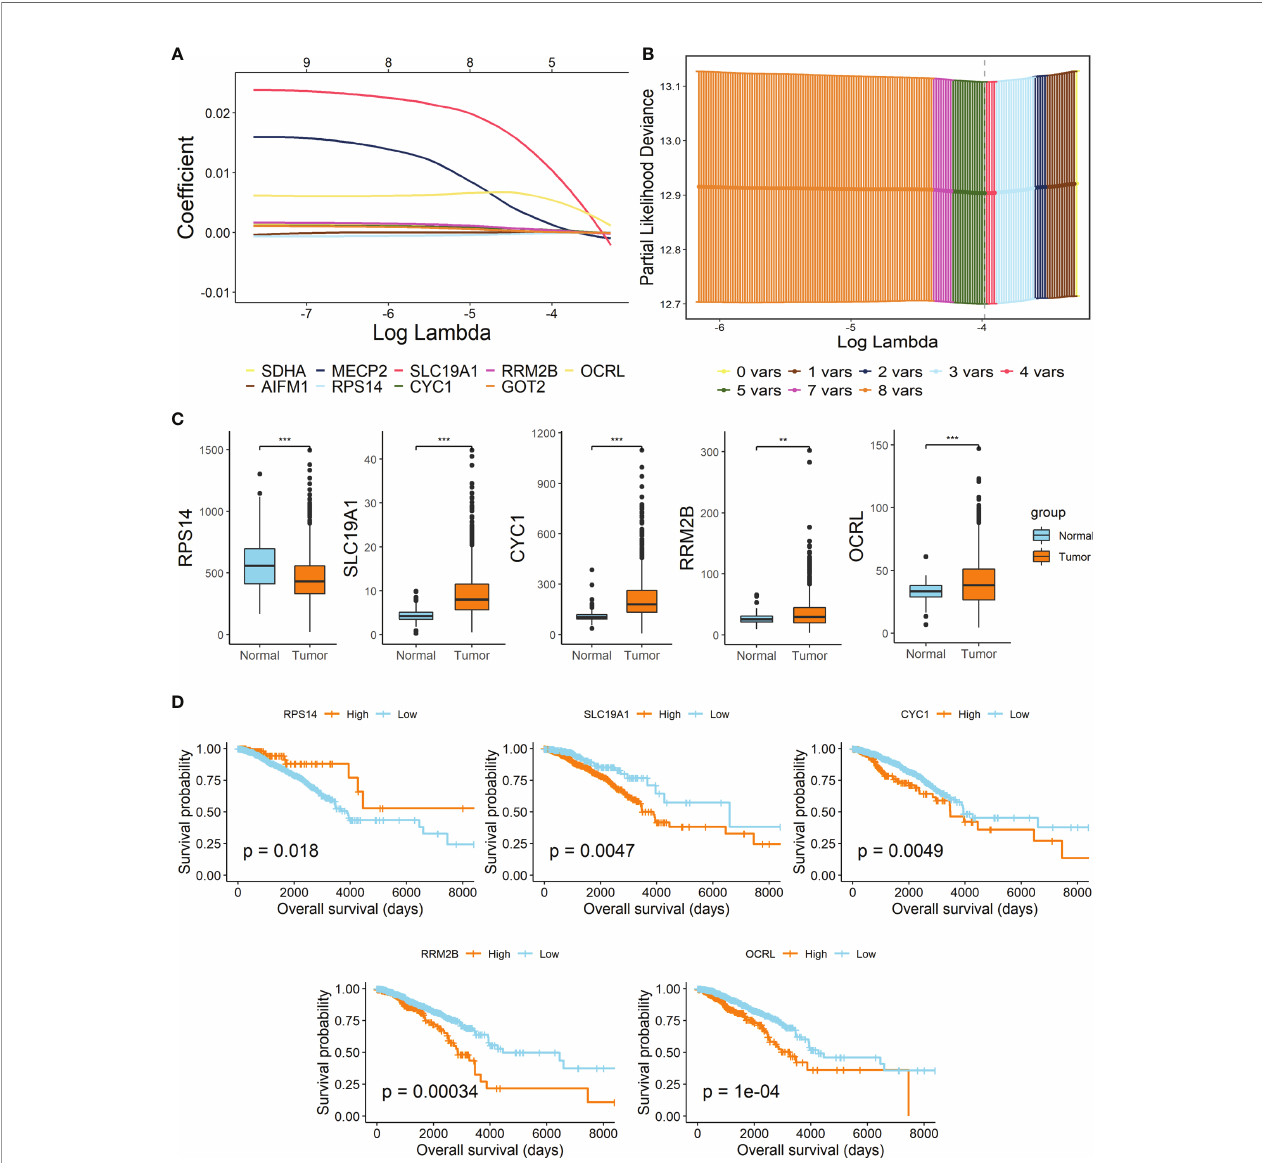
FIGURE 2 | Establishment of lactate metabolism-related signature in BC. (A) LASSO Cox regression analysis. (B) Partial likelihood deviance for the LASSO regression to screen out 5 optimal prognostic LMGs. (C) Boxplots showing the mRNA expression levels of 5 signature-contained LMGs in the training cohort. (D) KM survival curves of OS based on expression levels of 5 LMGs in the training cohort. **p < 0.01; ***p <